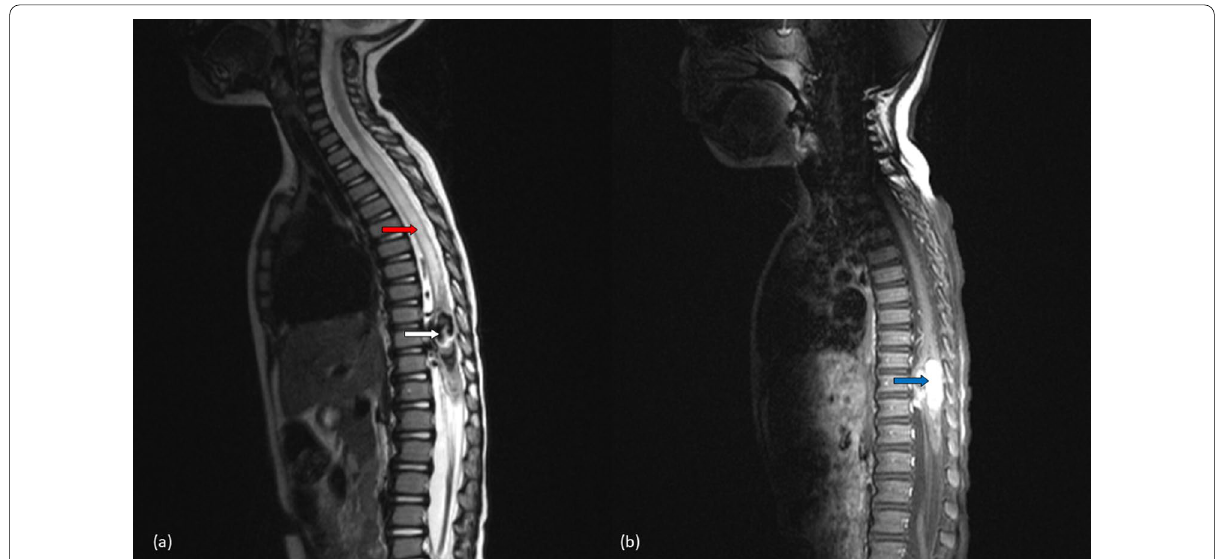
Fig. 1 a T2 weighted and b T1 weighted post-contrast sagittal Magnetic Resonance Imaging (MRI) images of the whole spine show peri- and intramedullary spinal AVM at D9–D11 spinal level (white arrow) with surrounding spinal cord edema extending from D1–D11 spinal level (red arrow). The post-contrast images show diffuse enhancement of the nidus (blue